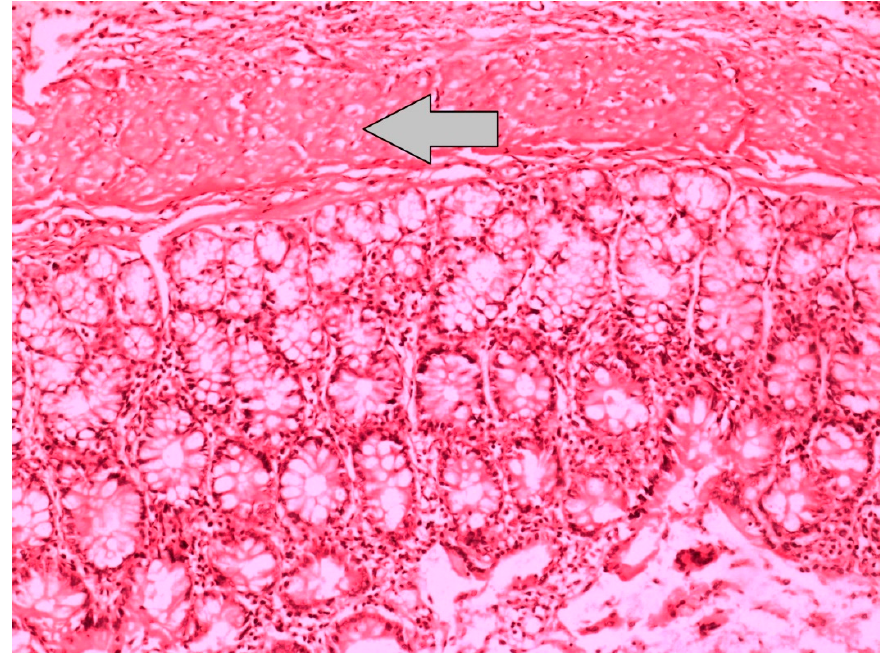
Figure 3. Histopathological image, which represents the grade 1 inflammation at the anastomotic line of the Sham-S group, demonstrates the intestinal mucosa, with no neutrophil infiltration and regular appearance of crypt structures and muscularis propria (H&E × 100).